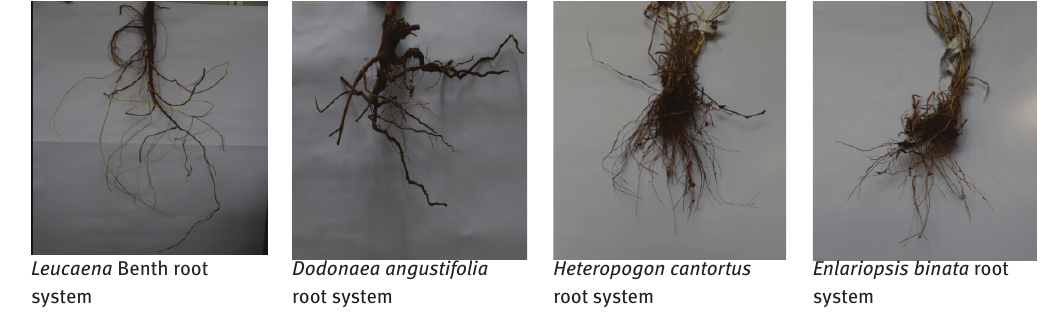
Figure 2: The morphological distribution of roots of the primary